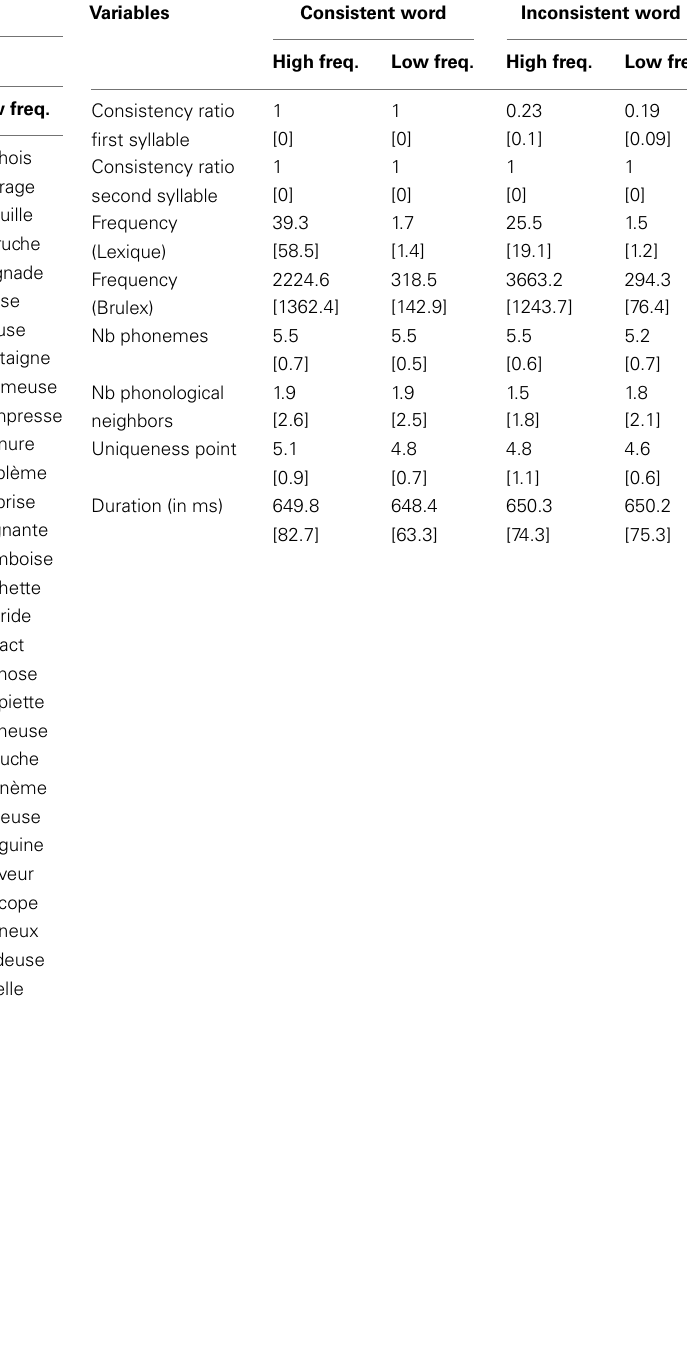
TableA2 | Characteristics of the critical stimuli (SD in